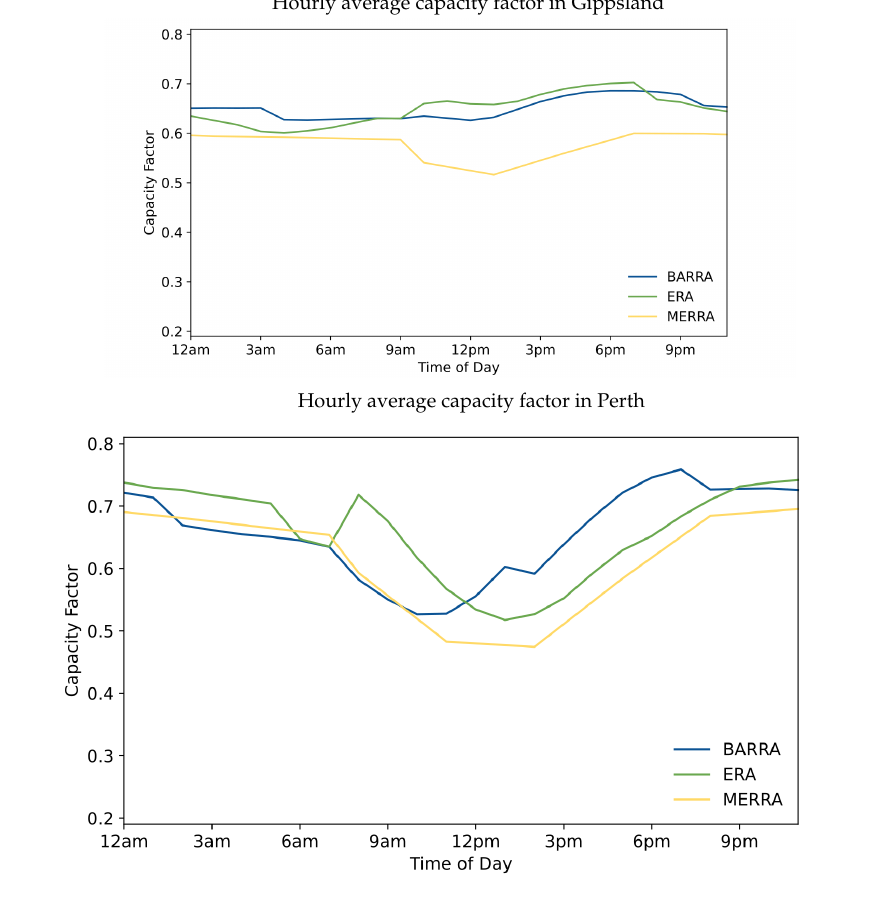
Figure 7. Comparison between hourly variation in average capacity factors predicted for Gippsland and Perth using each dataset. Table 4. Average correlation coefficient between capacity factors predicted using each dataset at key locations.